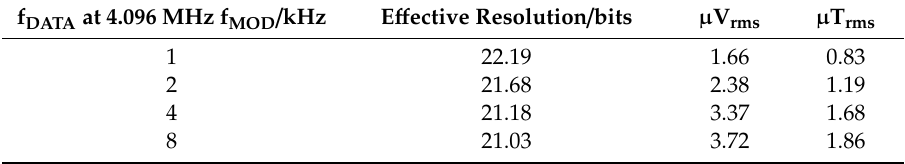
Table 1. Noise performance figures of the delta-sigma ADC for the di ff erent output data rates. f DATA at 4.096 MHz f MOD / kHz E ff ective Resolution /